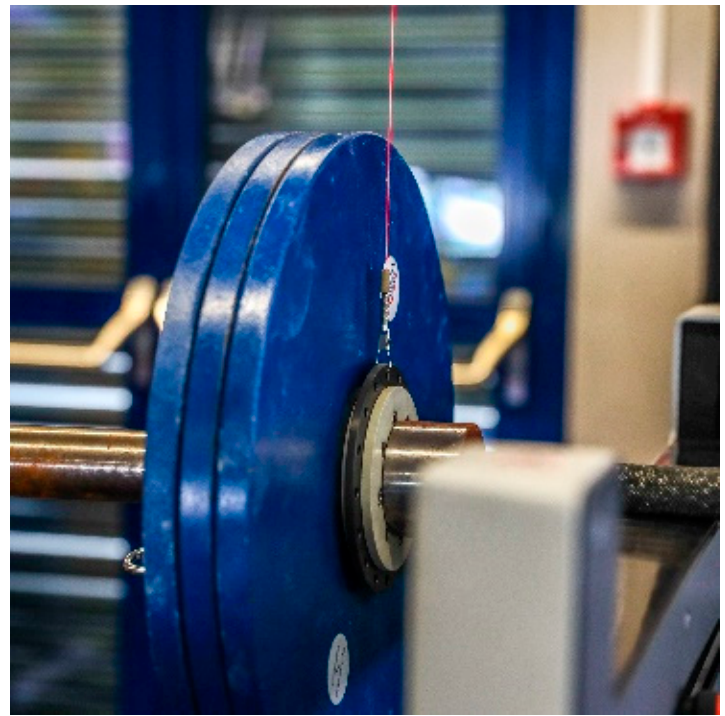
Figure 2. The draw-wire and plate of the draw-wire encoder.